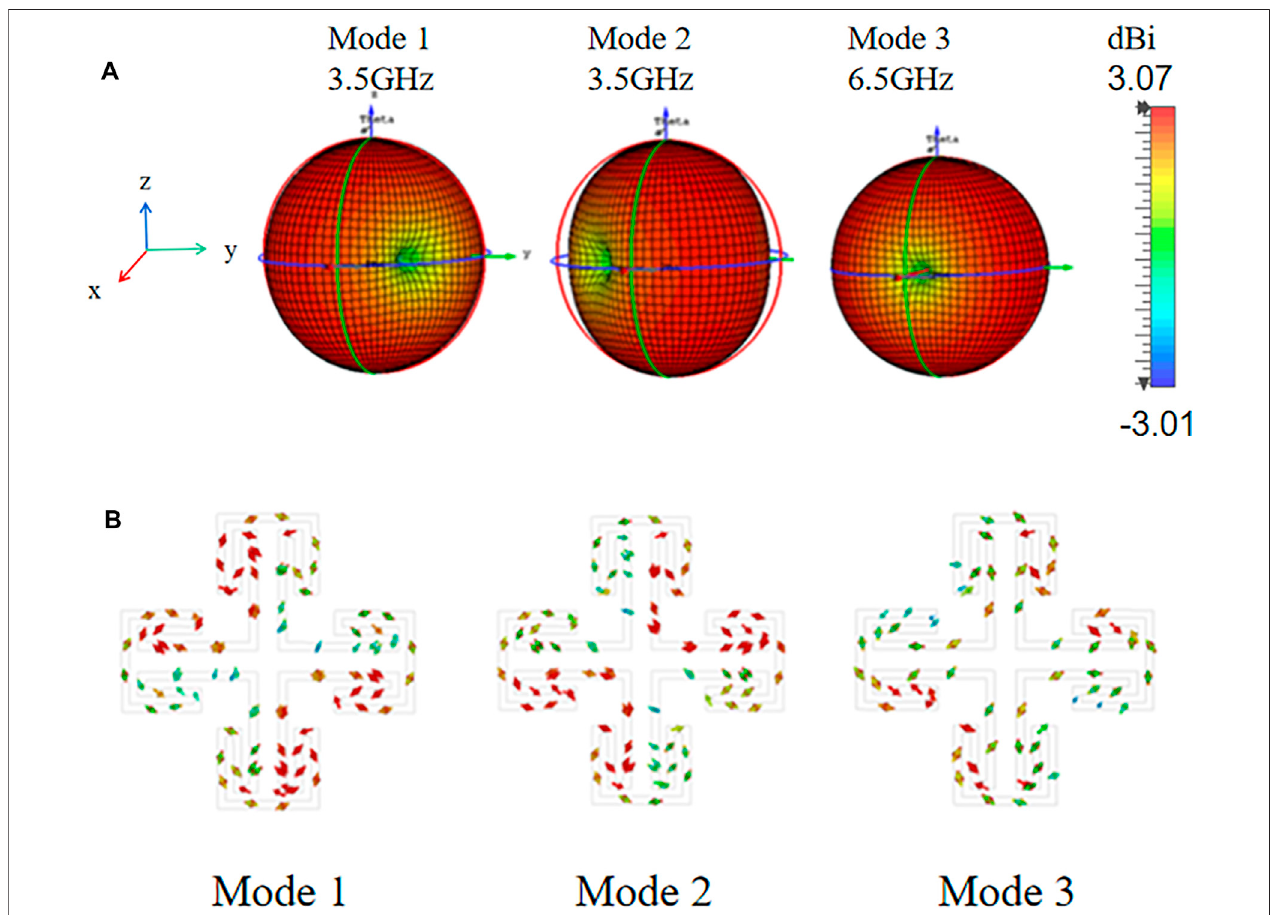
FIGURE 5 | (A) Mode fi elds of the modes. (B) Characteristic current of resonant frequencies.